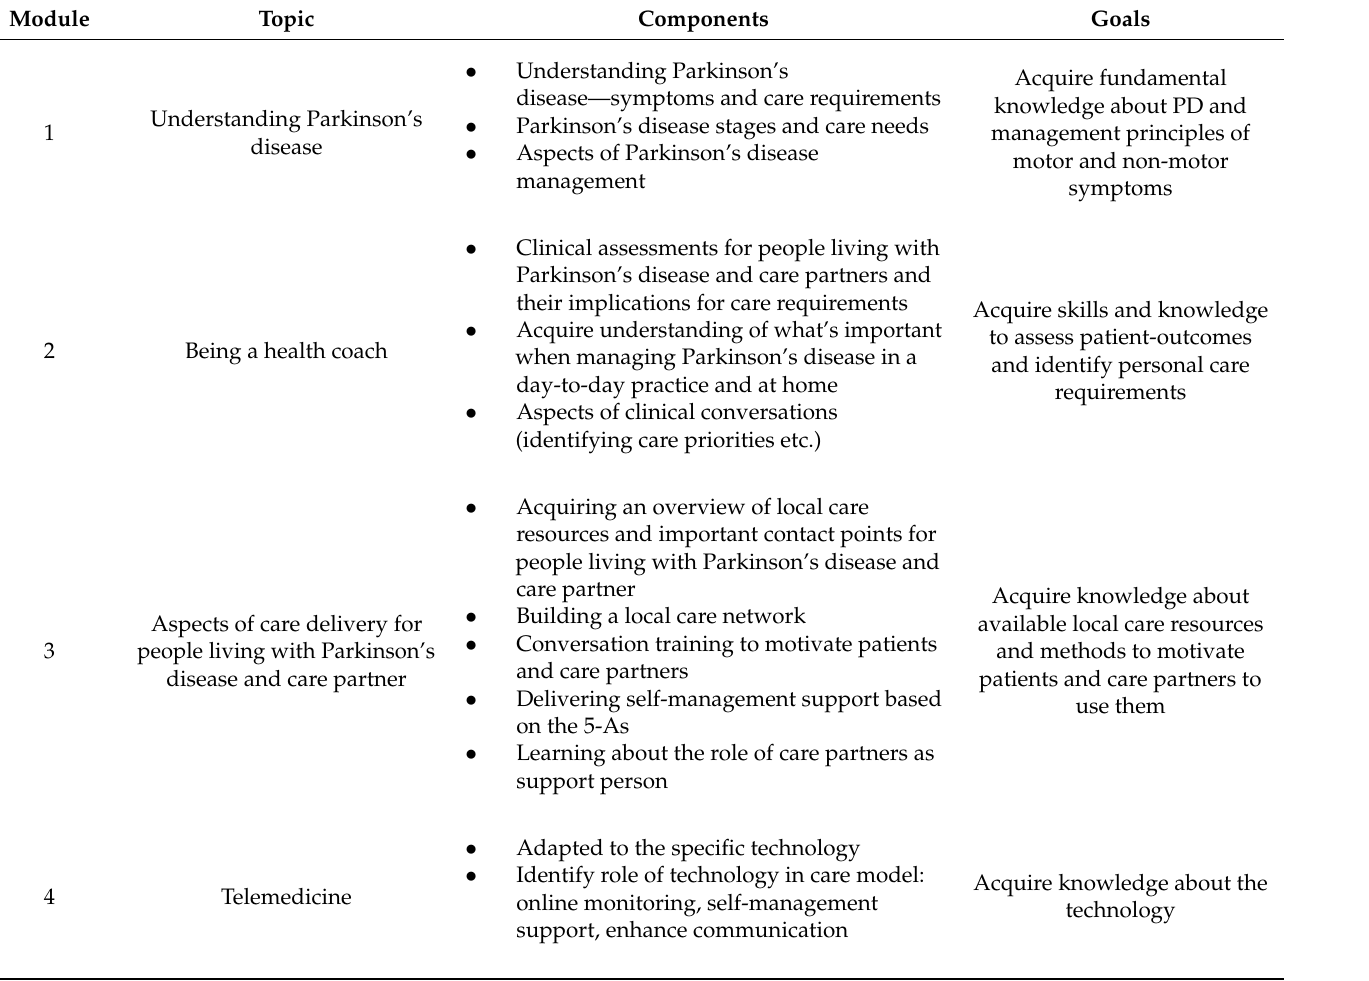
Table 4. Conceptual framework for training Parkinson-Nurses to deliver a personalized care approach. Module Topic Components Goals